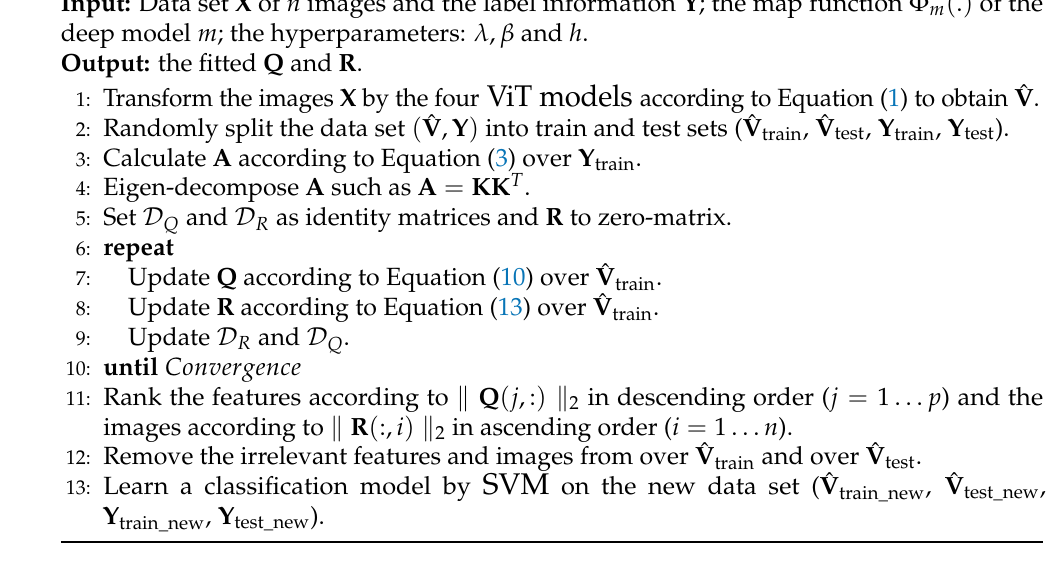
Algorithm 1 The Proposed Framework